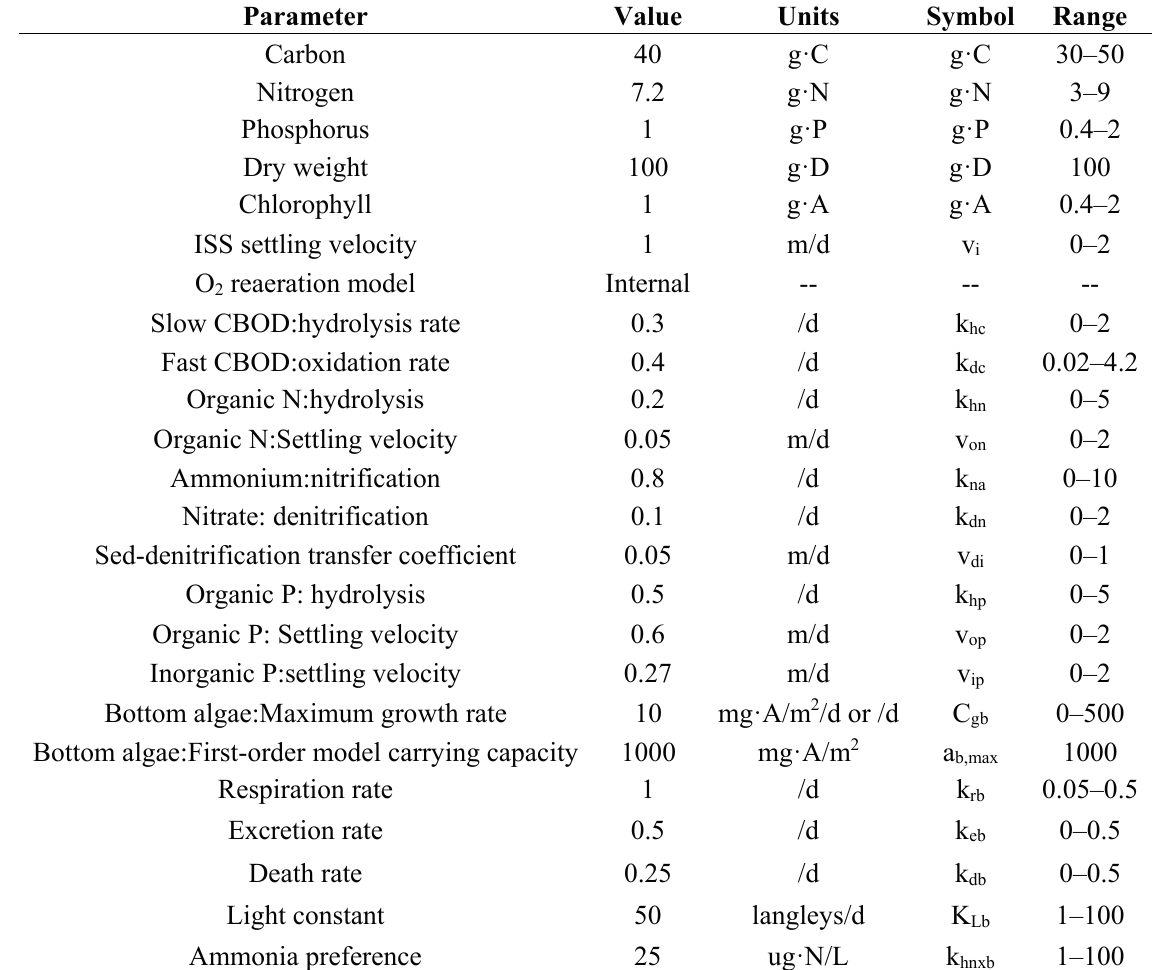
Table 3. Parameters of the QUAL2K model for the Tianlai